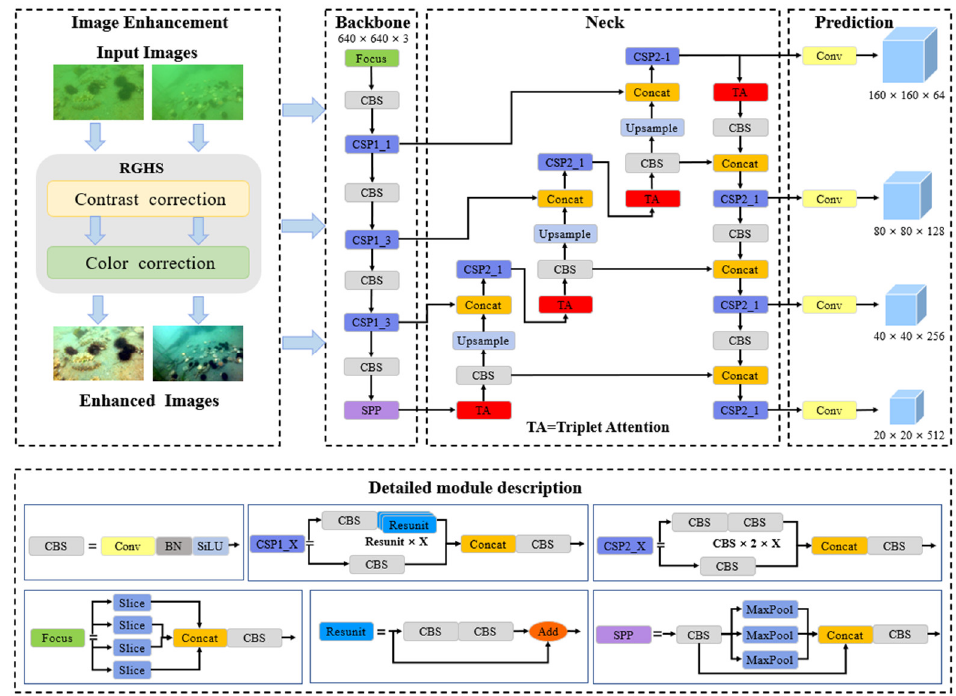
Figure 2. The architecture of the proposed marine organism identification model.